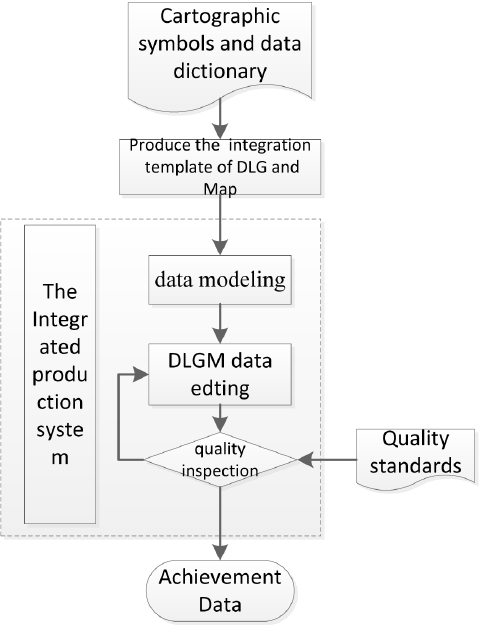
Figure 2: The flowchart of DLGM